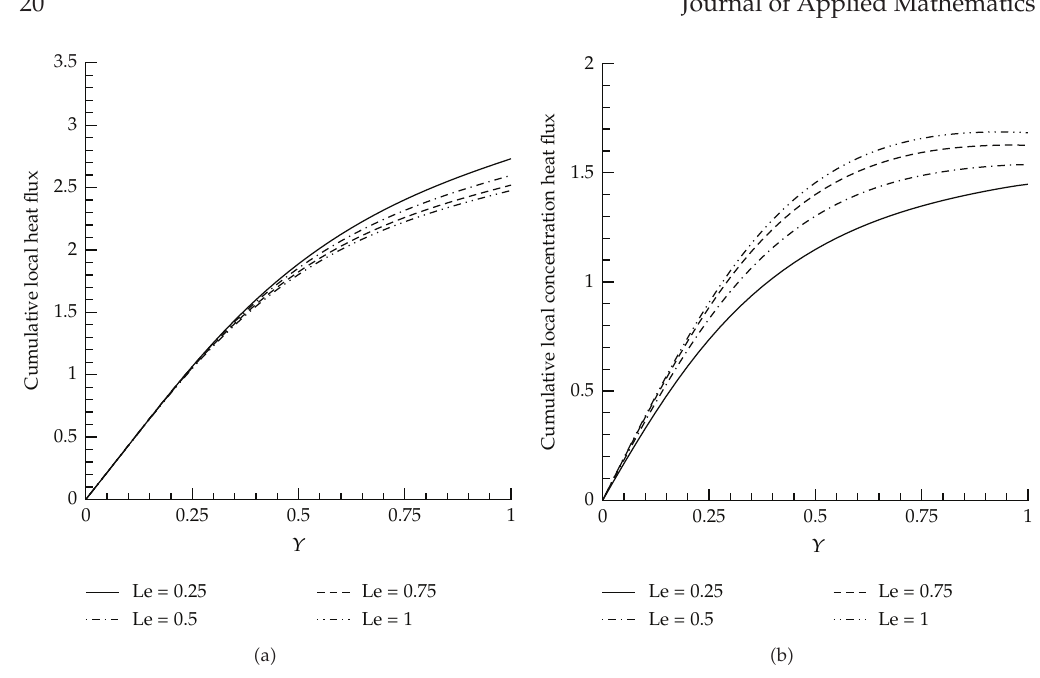
Figure 15: (cid:2) a (cid:3) Cumulative heat flux plots and (cid:2) b (cid:3) cumulative mass flux plots along the left vertical wall while fixing B (cid:8) 1, (cid:2) D/H (cid:3) (cid:8) 0 . 1, a (cid:8) 0 . 1, Ra (cid:8) 100, S C (cid:8) 0 . 1 for di ff erent values of